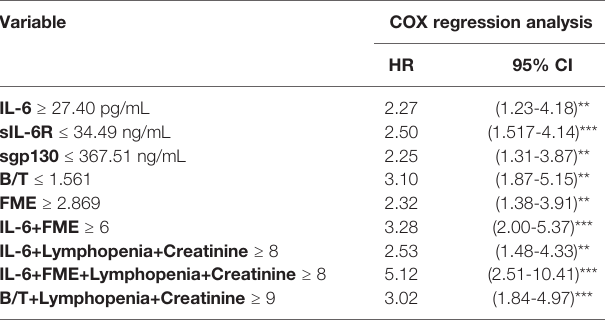
TABLE 5 | COX regression analyses of IL-6 signalling components as predictors of COVID-19 mortality based on proposed scores. Variable COX regression